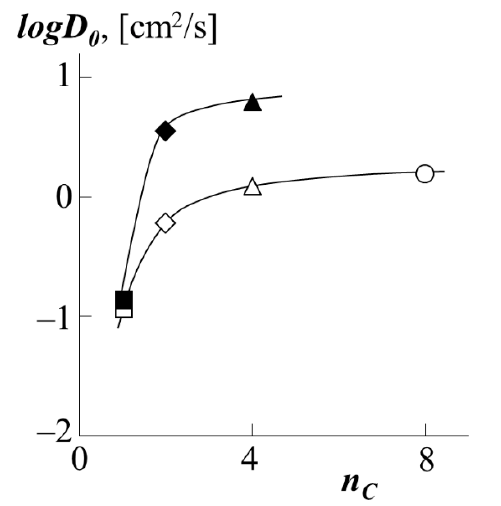
Figure 13. Dependence of the reptational constant D 0 during the movement of PS-1 (white dots) or PS-2 (black dots) into the matrix of PBA (triangle), PEA (rhombus), PMA (square) or PEHA (circle) on the number of carbon atoms in side chains of n C polyacrylate at 433 K.